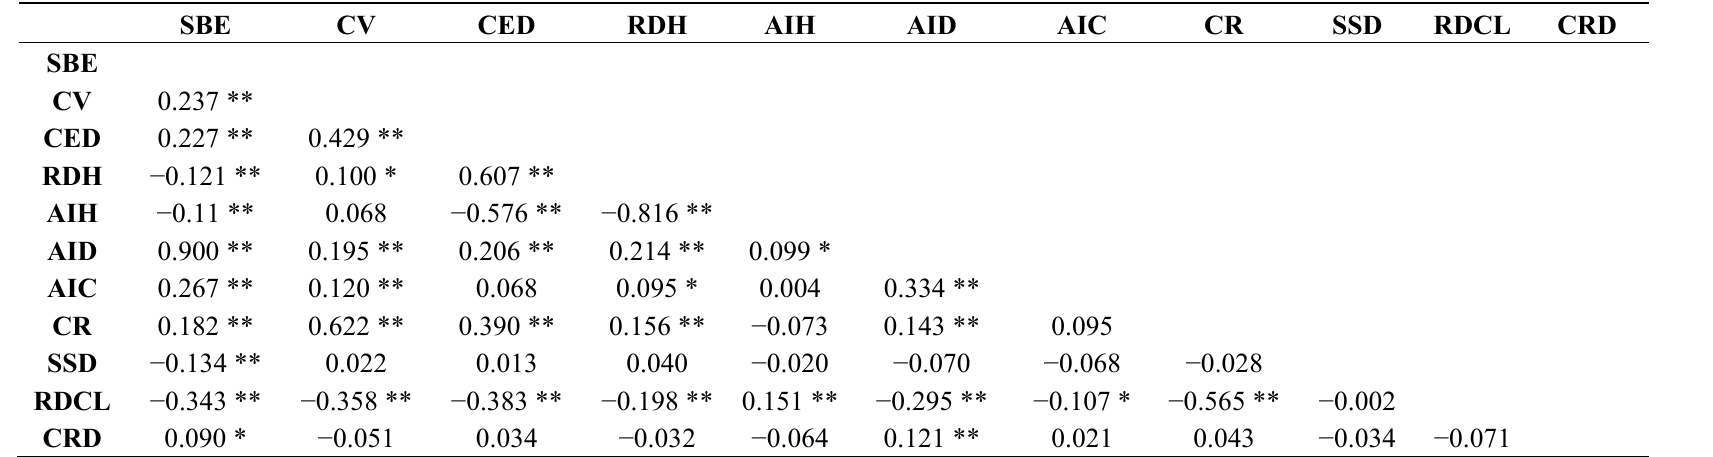
Table 5. Significance correlations between indicators of individual